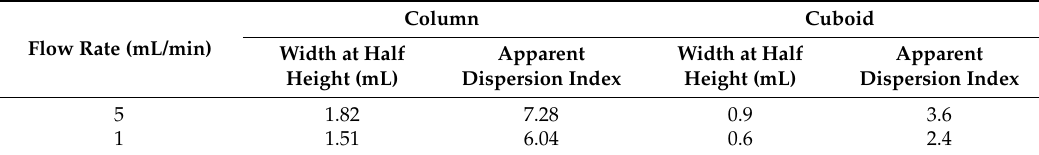
Table 3. Comparison of the attributes of the eluted BSA peaks obtained with the best cuboid packed-bed device and its equivalent column (media: Capto Q anion exchange, bed volume: 5 mL, binding buffer: v S = 30 and 150 cm/h for the flow rate of 1 and 5 mL/min respectively, injection volume: 0.5 mL)